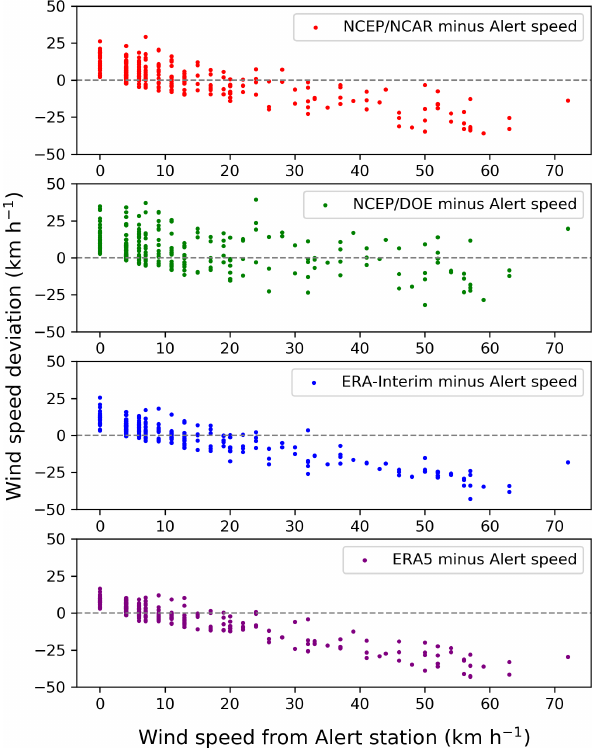
Figure 2. Deviation of the reanalysis wind speed from the speed measured at the Arctic Alert weather station (reanalysis wind minus station wind) for the period 1 October 2016 to 30 April 2017. The reanalysis data are from NCEP/NCAR, NCEP/DOE, ERA-Interim and ERA5. Note the increasing underestimation of the reanalysis data as the measured wind increases. Units of the x axis in the bot- tom segment apply to all